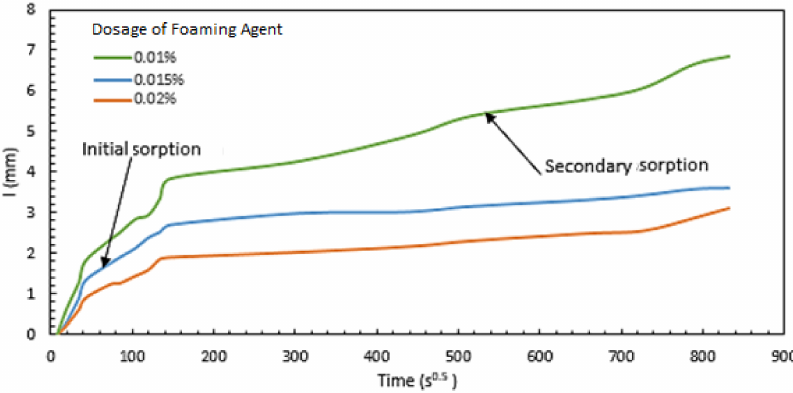
Figure 9. Capillary sorption of aerated slurries versus the square root of